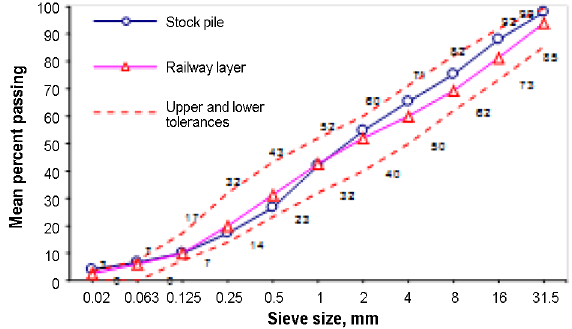
Fig. 11. Conformity of the average gradation of ASB mixture type KG1 samples, taken from different locations, to the technological requirements